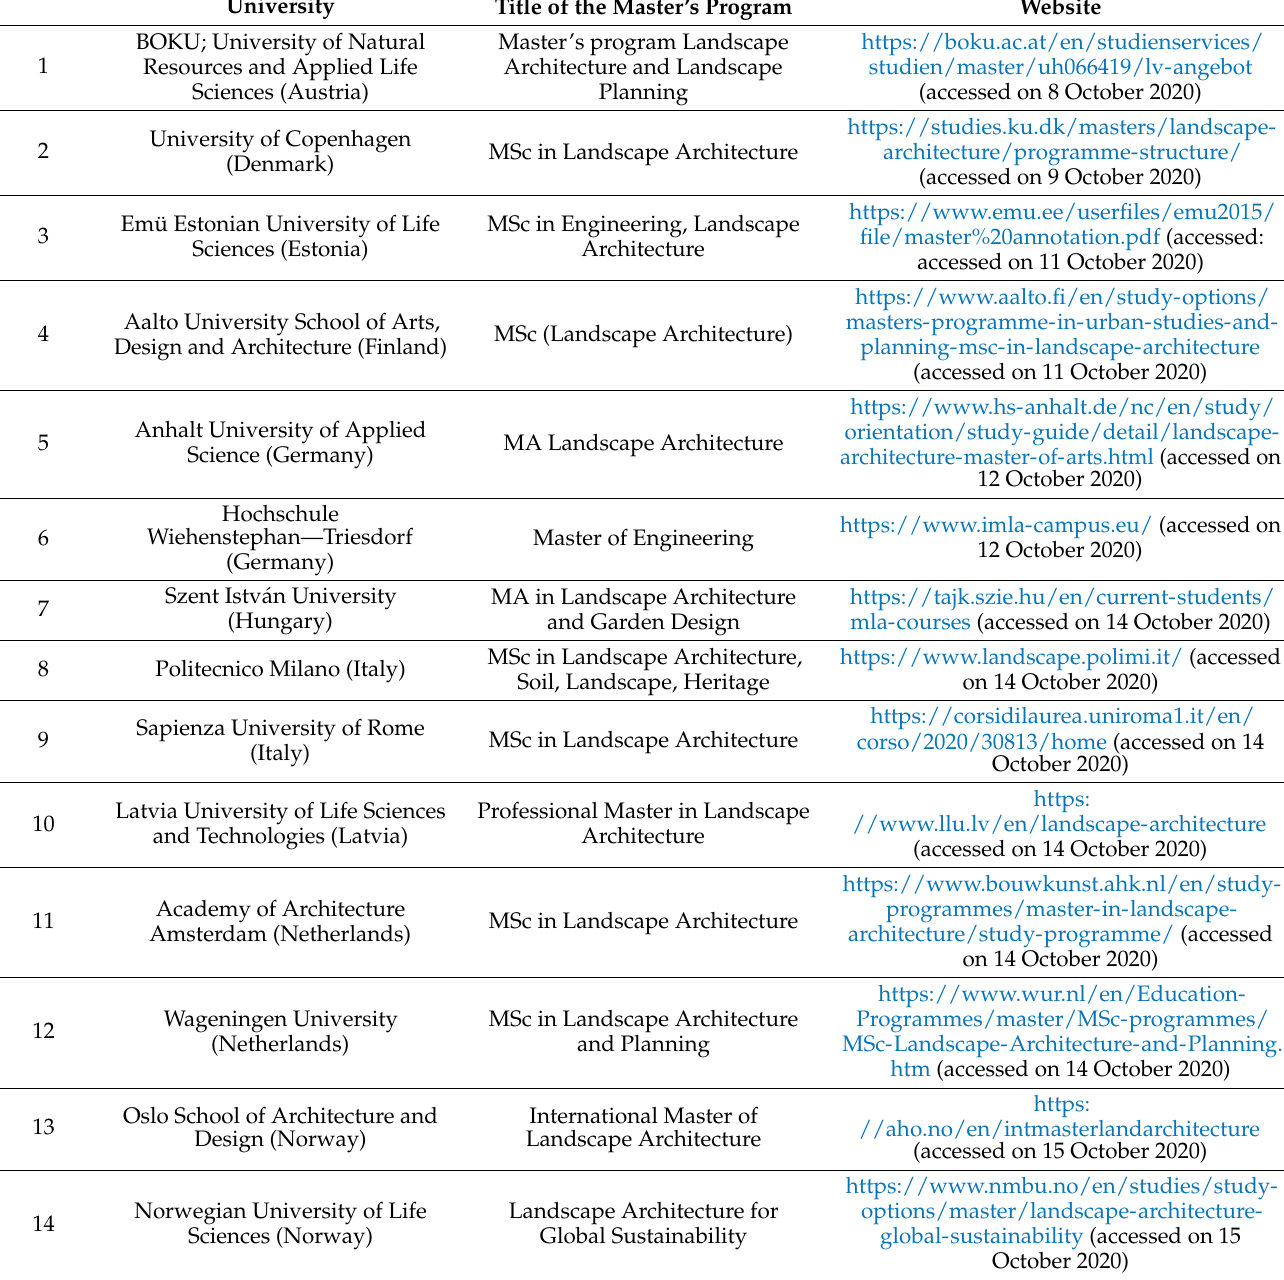
Table 1. List of institutional ECLAS members with an international master’s in Landscape